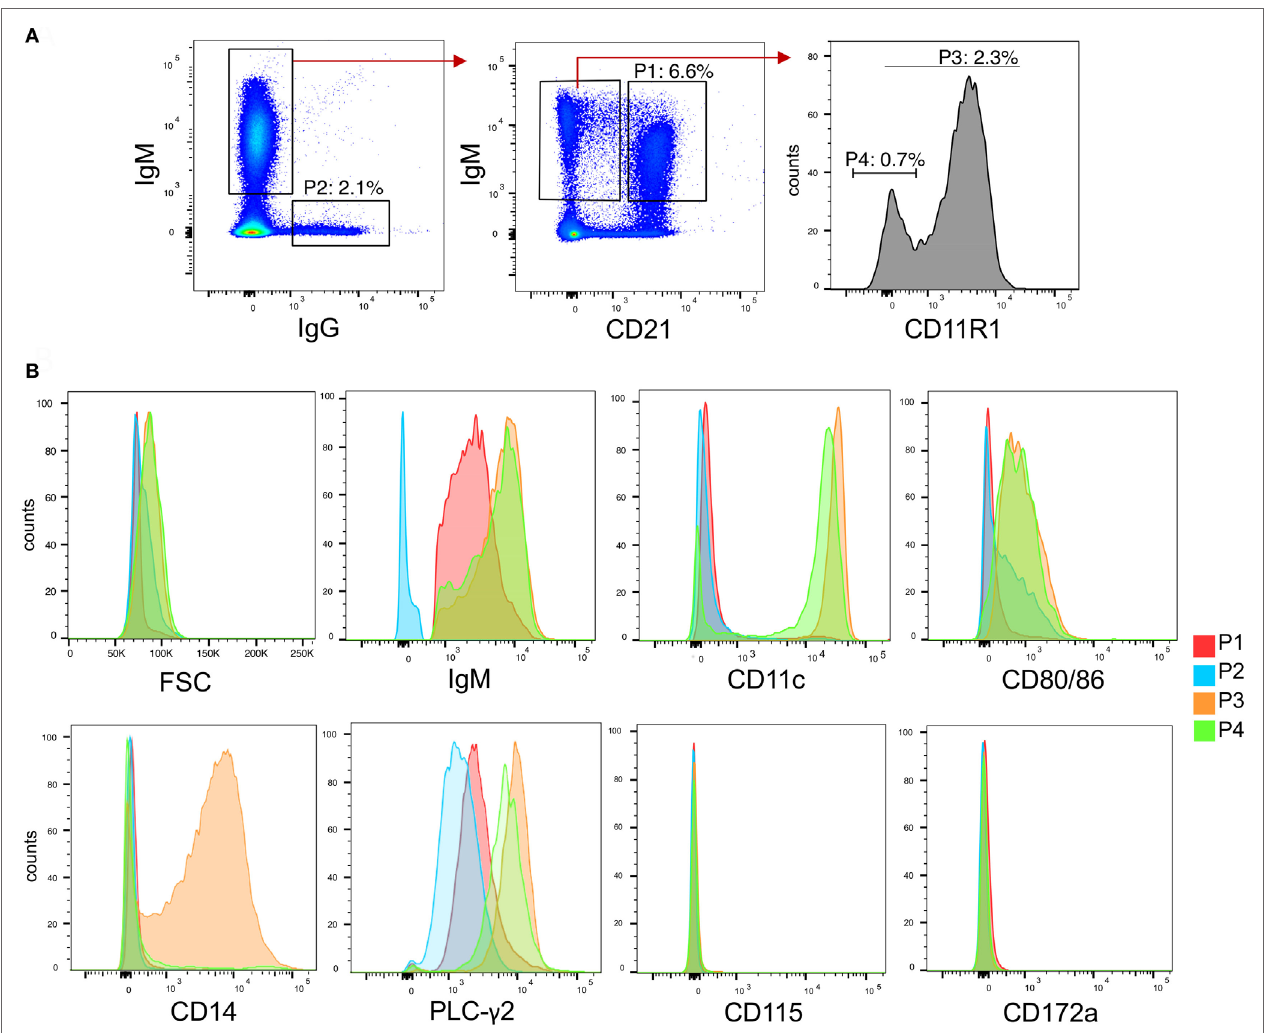
FigUre 2 | B cell subsets in peripheral blood of pigs. (a) Gating strategies for identifying B cell subsets based on expression of IgG, IgM, CD21, and CD11R1. After doublet exclusion, population 1 (P1) was defined as CD21 + IgM + , P2 as IgG + , P3 as CD21 − IgM + CD11R1 + , and P4 as CD21 − IgM + CD11R1 − . (B) Histogram overlays of FSC, IgM, CD11c, CD80/86, CD14, phosphor-PLC- γ 2, CD115, and CD172a for the subsets P1–P4 identified in (a) . A representative animal out of three is